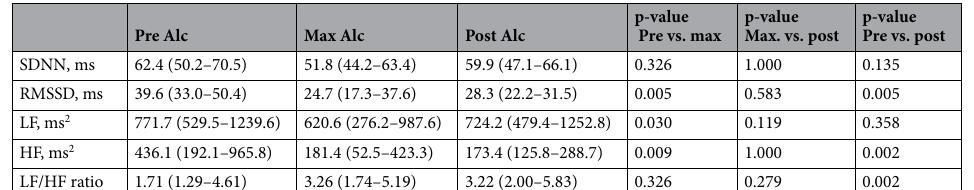
Table 1. Standard HRV parameters. N = 15 for all experiments and analyses. Differences were tested by the Wilcoxon signed-rank test. HRV heart rate variability, SDNN standard deviation of NN intervals, RMSSD root mean square of successive differences, LF low frequency, HF high frequency, Pre Alc before alcohol intake, Max Alc maximum blood alcohol concentration, Post Alc after alcohol intake.